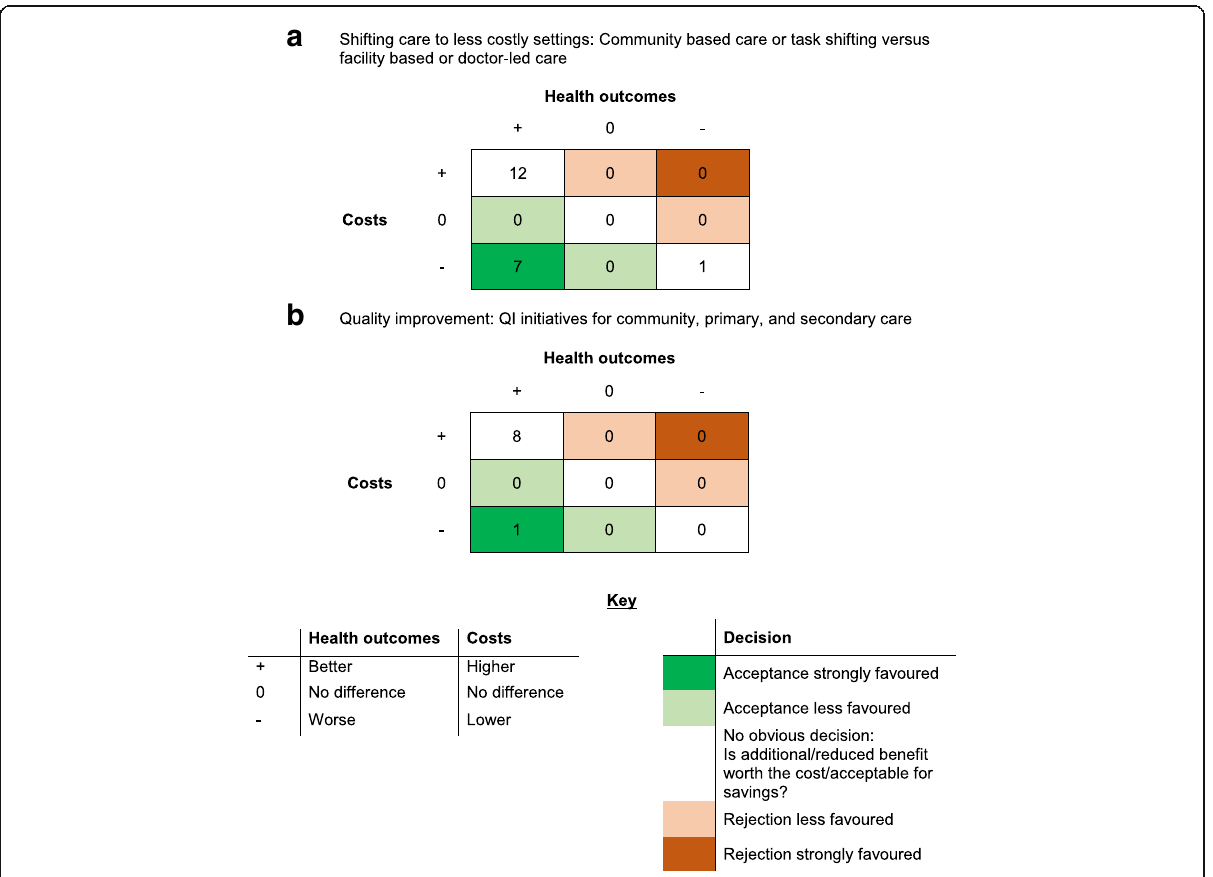
Fig. 2 Permutation plots summarising the number of economic evaluations according to their findings. Numbers in cells represent numbers of studies. a Shifting care to less costly settings: Community based care or task shifting versus facility based or doctor-led care. b Quality improvement: QI initiatives for community, primary, and secondary